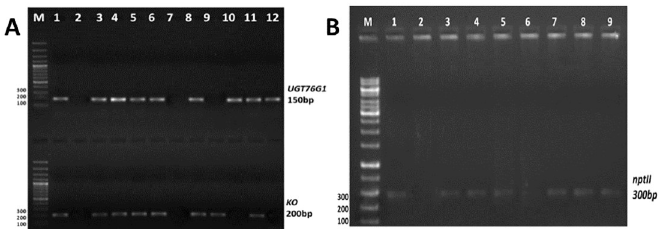
Fig 6. A: Confirmation of putative transgenic lines by amplifying the UGT76G1 and KO specific primers. Out of 10 transgenic lines, only 7 were positive for both the genes, B: transgenic lines which were positive for both the genes were further confirmed by the presence of nptII gene. M = 100b ladder (Fermantas) Lan 1 = positive control, Lane 2 = non- transformed control, Lines for nptII were selected for further